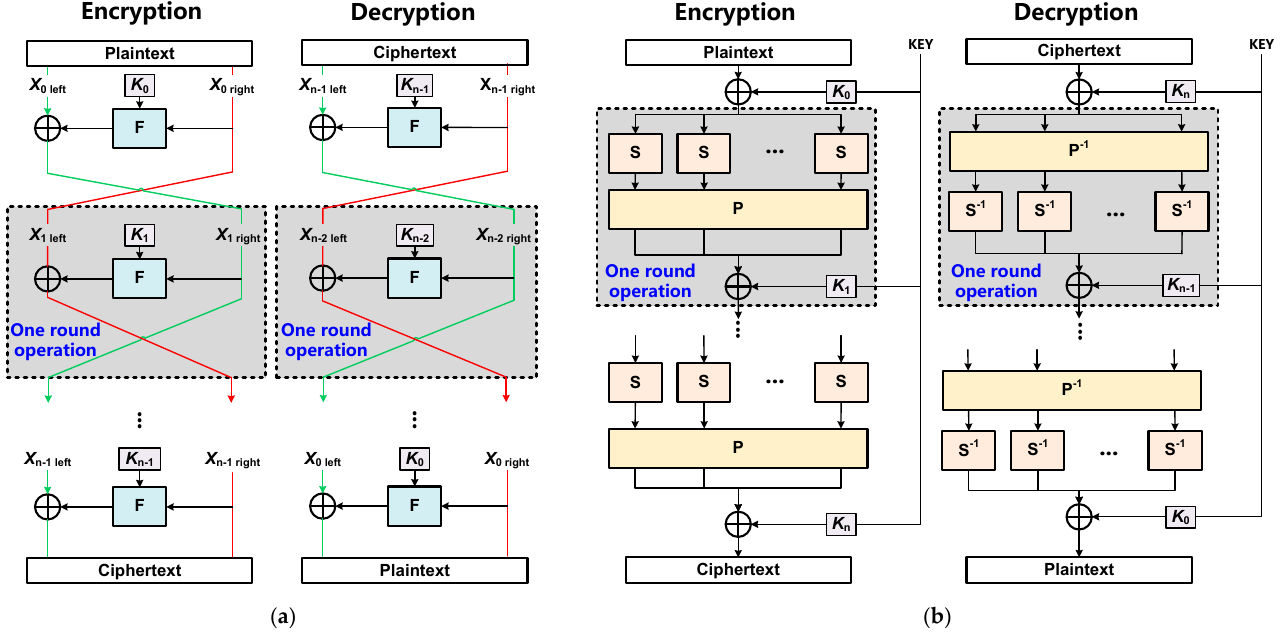
Figure 1. ( a ) Round operation structure of Feistel, ( b ) Round operation structure of SP.